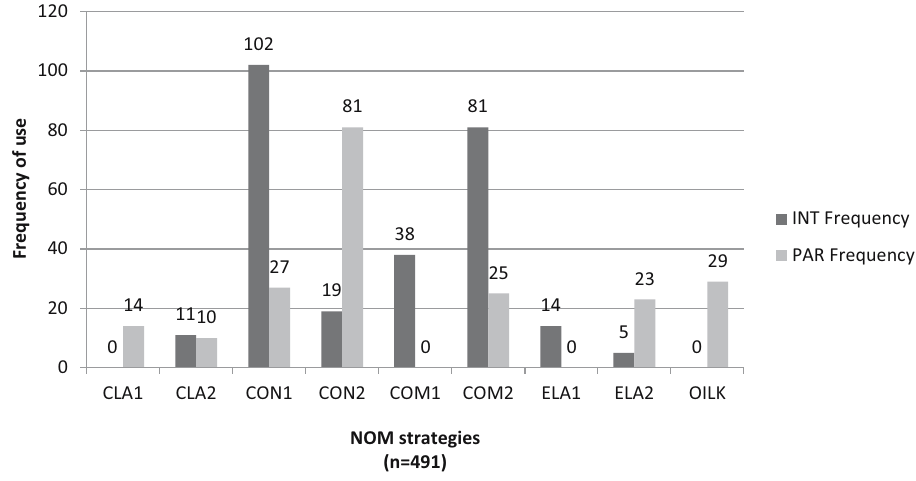
Figure 1: Comparison of the frequency of use of each NOM strategy by participants and